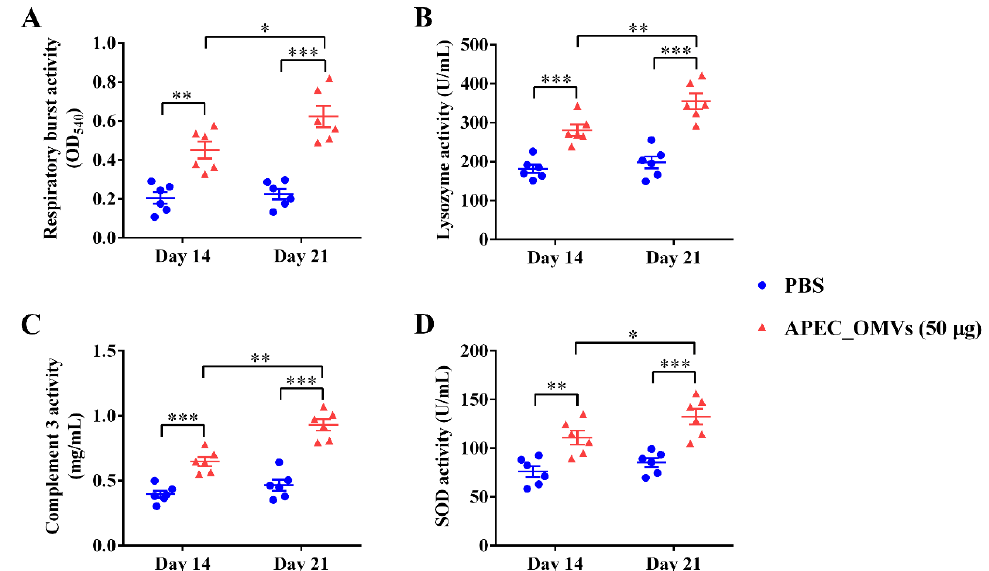
Figure 6. Effects of APEC_OMV vaccination on non-specific immune factor activities in the serum. Serum samples were collected from PBS- and APEC_OMV (50 μ g)-immunized chicks at 14 and 21 days of age (one week after the primary and secondary immunization, respectively) before the secondary APEC_OMV immunization or bacterial challenge to determine the activities of the following immune factors: ( A ) lysozyme; ( B ) complement 3; ( C ) respiratory burst; ( D ) SOD. Data are presented as mean ± SE (n = 6). * p < 0.05; ** p < 0.01; *** p < 0.001.